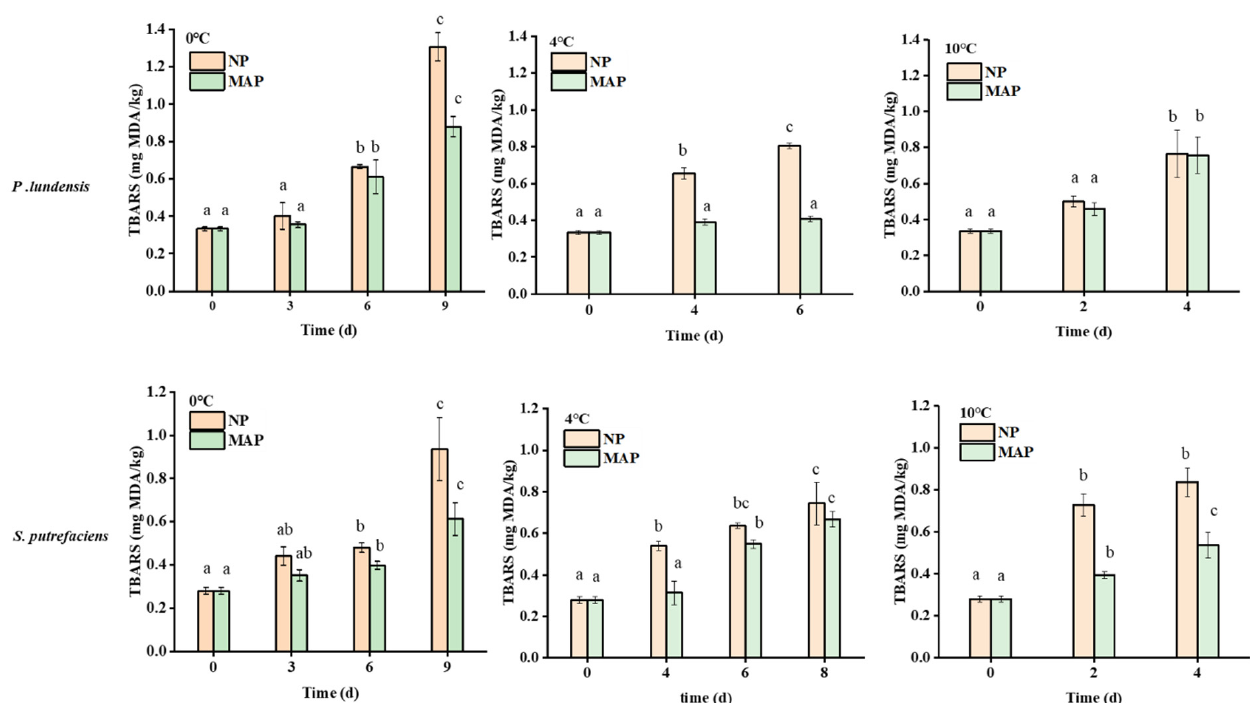
Figure 3. Effect of normal packaging (NP) and modified atmosphere packaging (MAP) on the TBARS values of chicken breast meat. Lowercase letters: significance of dominant spoilage bacteria at different storage times.